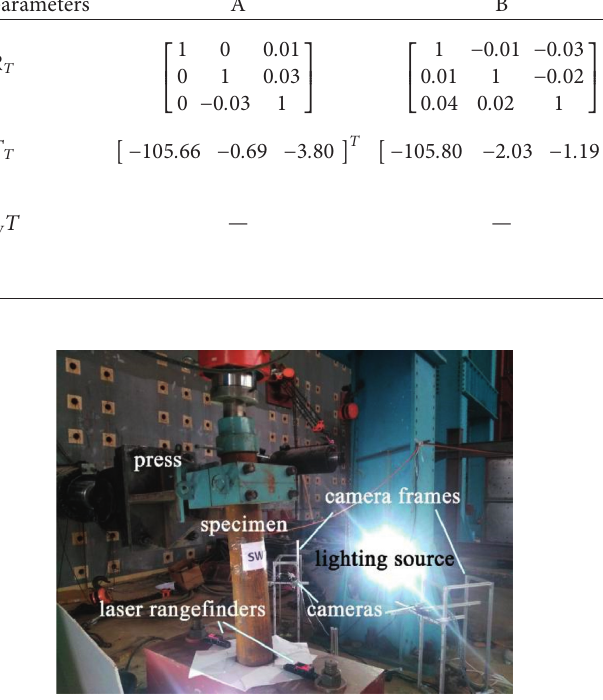
Figure 17: Equipment settings.